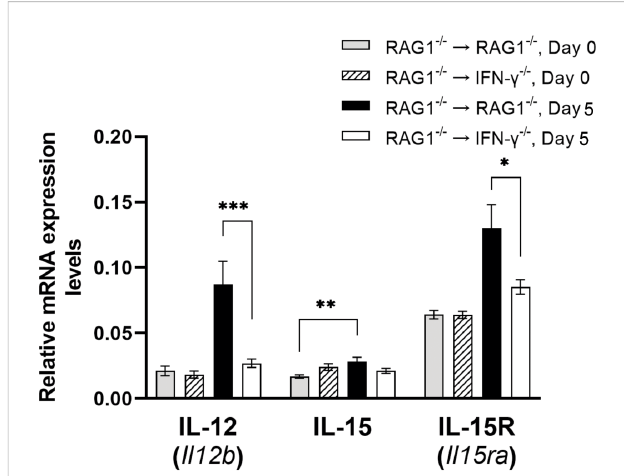
FIGURE 9 Cerebral mRNA levels for the cytokines that facilitate IFN- g production by NK and T cells are upregulated by IFN- g production by brain- resident cells during reactivation of cerebral T. gondii infection. For the details of experimental methods, see the legend of Figure 1. The mRNA levels for IL-12, IL-15, and IL-15R were measured at both Day 0 and Day 5 in the brains of both groups of mice were measured using NanoString nCounter Mouse Myeloid Innate Immunity Panel. * P <0.05, ** P <0.01, and *** P <0.001. The data were combined from two independent experiments (n=5 for Day 0 and n=7 for Day 5 in